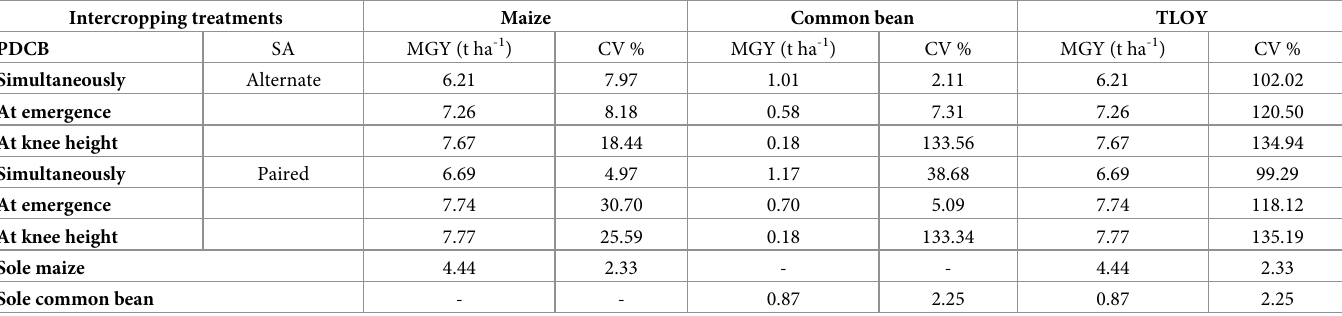
Table 7. Coefficient of Variation (CV %) for maize, common bean grain yield and TLOY in maize-common bean intercropping in north western Ethiopia a . Intercropping